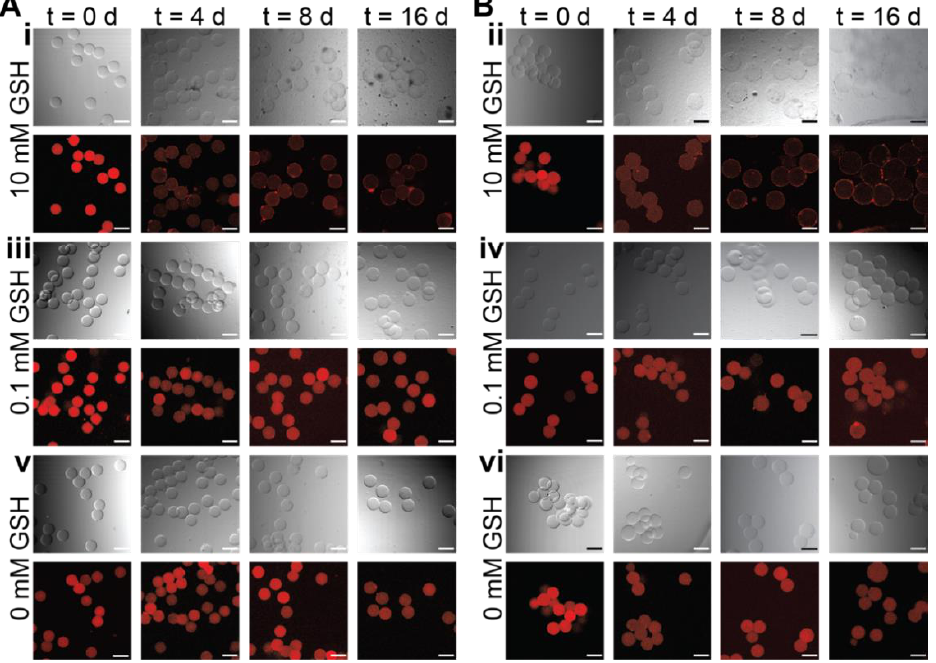
Figure 4. Degradation of microgels containing redox-sensitive crosslinks . Microgels containing 50% ( A ) or 90% ( B ) redox-sensitive crosslinks and 5 mg/mL 70 kDa dextran-TRITC were incubated in either 10 mM GSH ( i , ii ), 0.1 mM GSH ( iii , iv ), or PBS pH = 7.4 ( v , vi ). Representative brightfield (top) and fluorescent (bottom) images of the microgels at 0, 4, 8, and 16 days are shown. Scale bars = 50 µm.